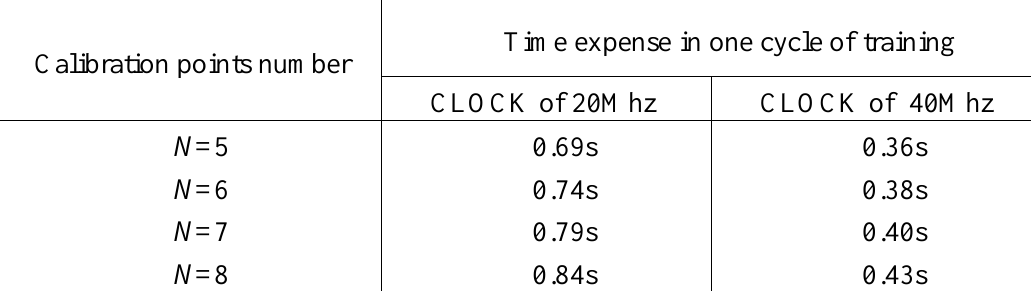
Table 3 . Time expense in the ANN